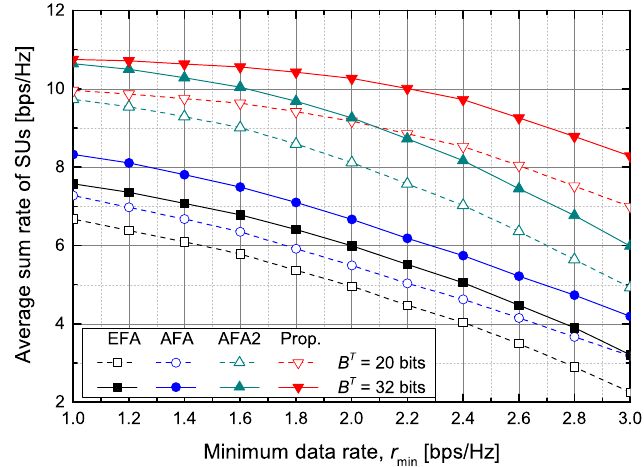
Figure 9. The achievable average sum rate of SUs versus the minimum data